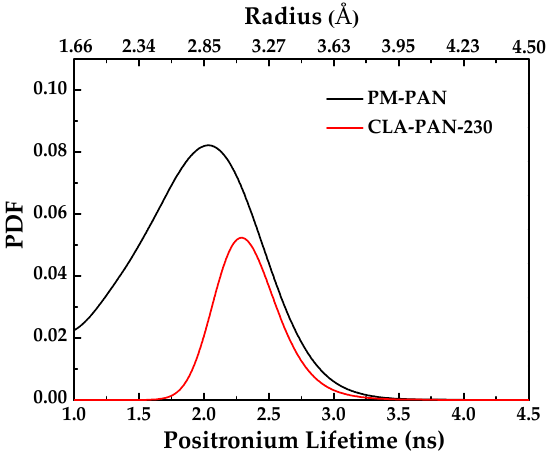
Figure 8. o-Ps lifetime distribution data for PAN and CLA-PAN-230 membranes.